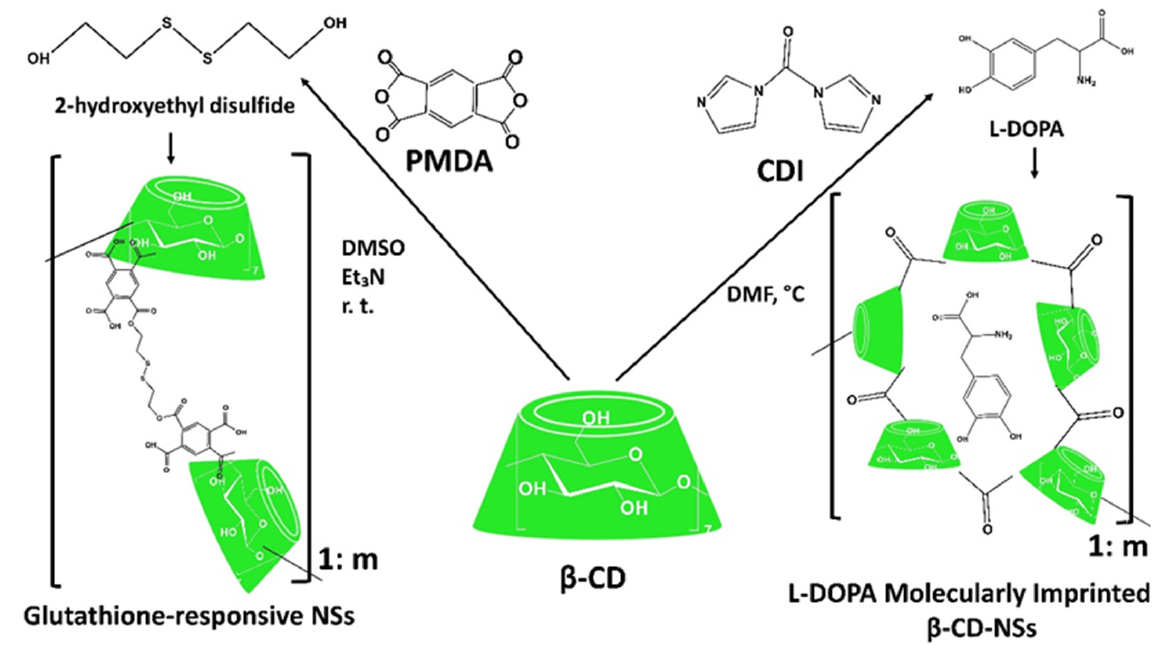
Figure 14. Schematic representation of the synthesis of glutathione-responsive NSs, and molecularly imprinted CD-based carbonate NSs (L-DOPA used as a template).